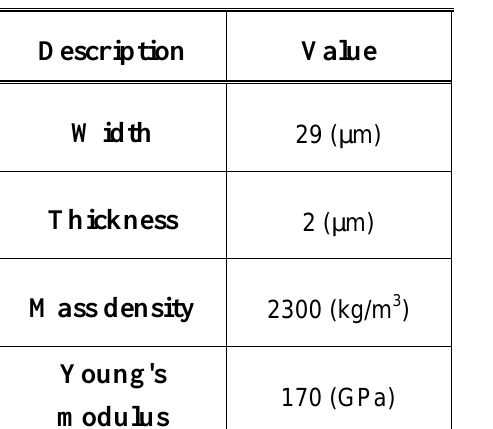
Table 1. Cantilever